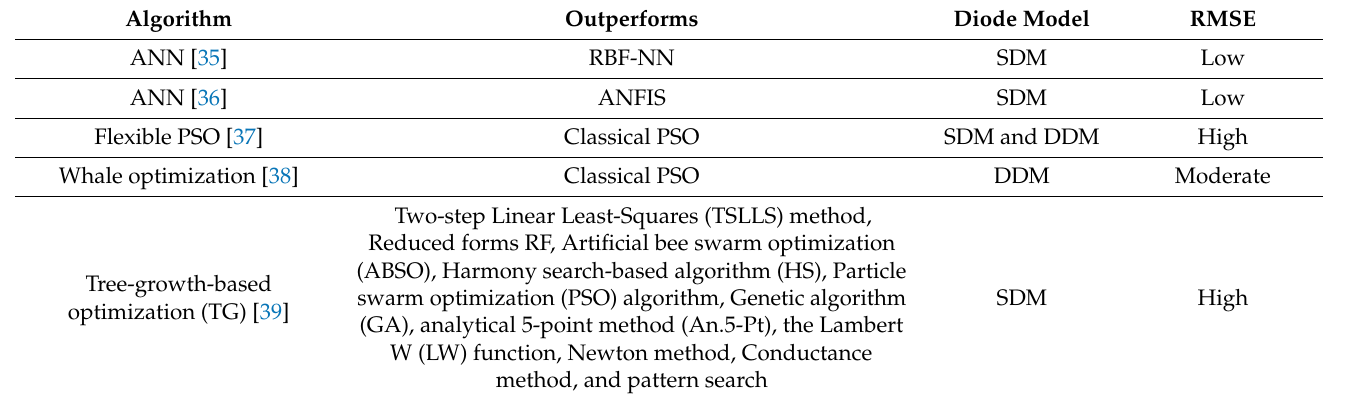
Table 4. Comparison of the parameter identification models.